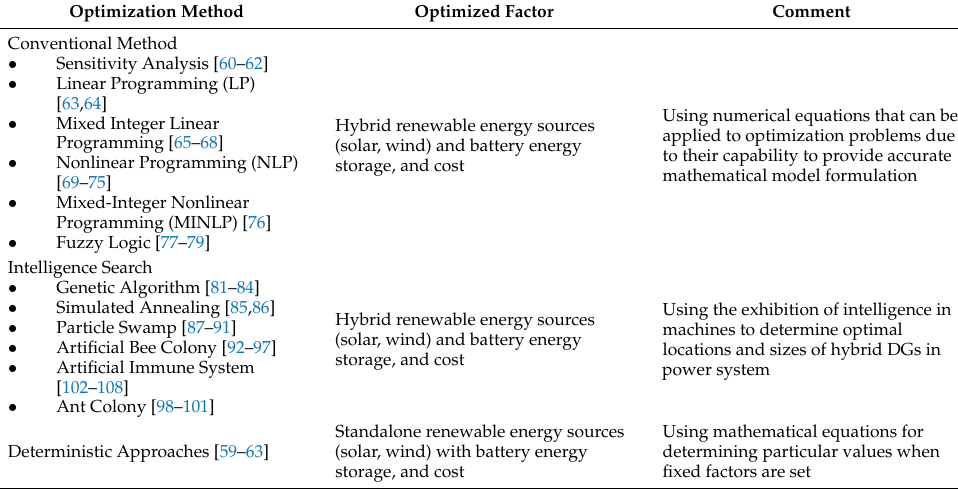
Table 2. Summary of optimization